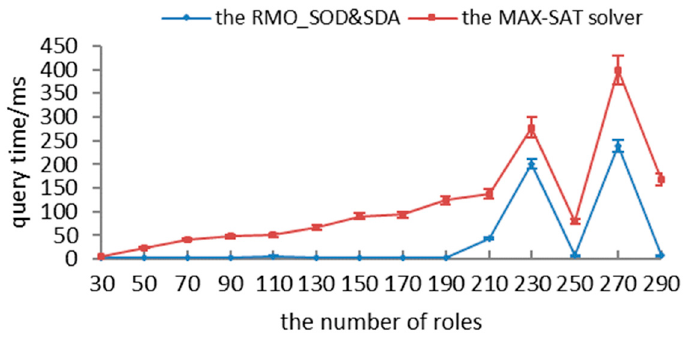
Figure 4. Query comparison when match = min.